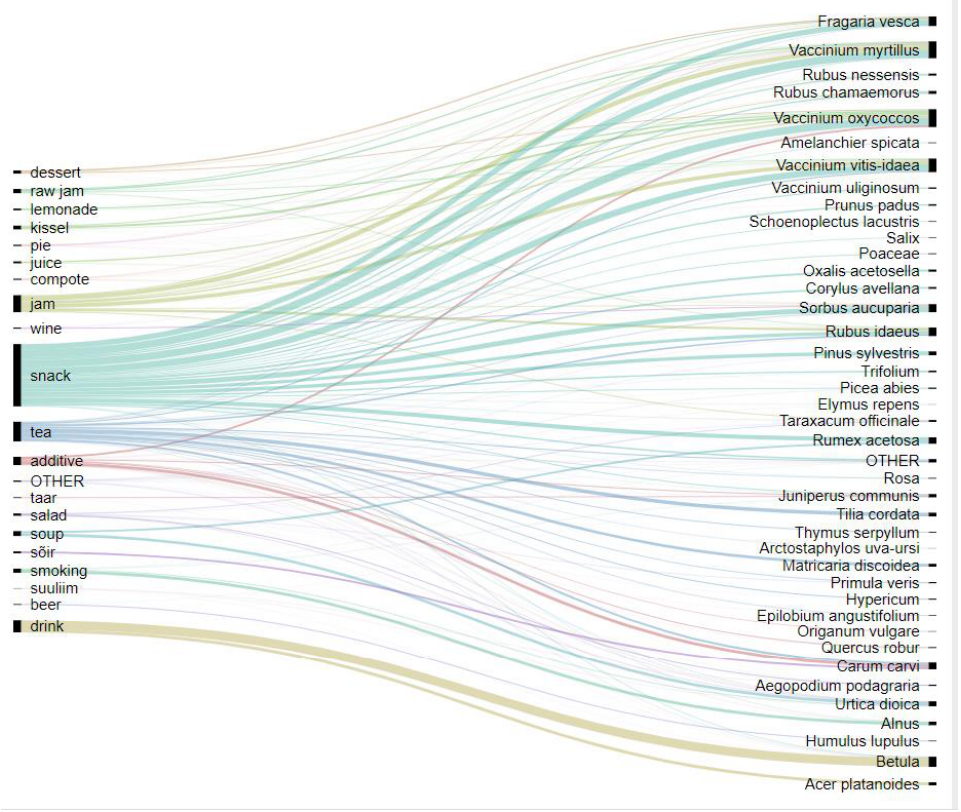
Figure 2. Alluvial diagram of the relationship between the food made and the wild taxa used by both Seto and Estonians together. “Other” refers to taxa / uses with less than 4 detailed use records (DUR).